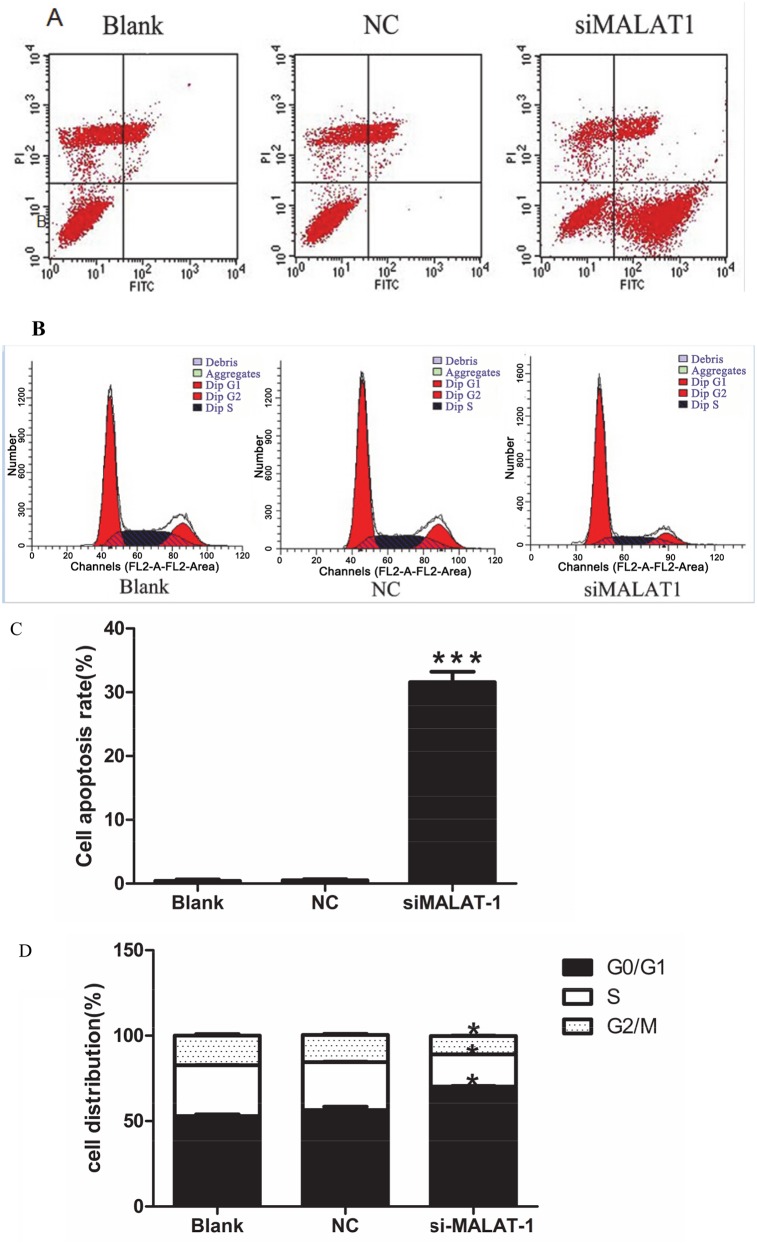
Effects of MALAT-1 knockdown on tumor cell apoptosis and cell cycle arrest.(A) Knockdown of MALAT-1 led to tumor cell apoptosis. OVCAR3 cells transfected with MALAT-1 shM3 were analyzed by flow cytometry for apoptosis. (B) Knockdown of MALAT-1 led to cell cycle arrest. OVCAR3 cells transfected with MALAT-1 shRNA3 were analyzed by flow cytometry analysis for cell cycle distribution. (C) Quantification of data in A. ***p < 0.0001 versus controls. (D) Quantification of data in B, *p < 0.05 versus controls.